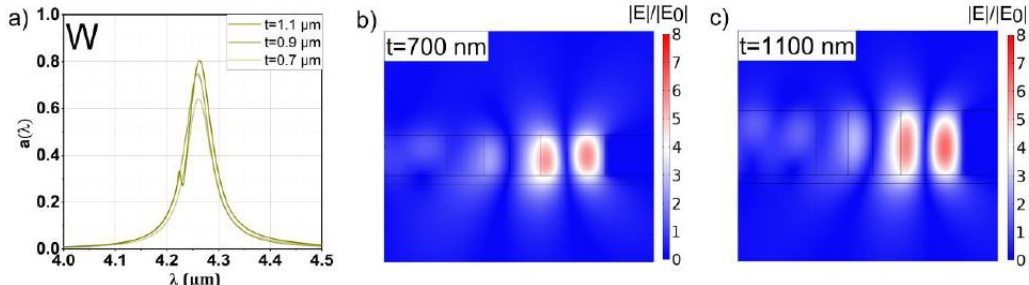
Figure 5. ( a ) Spectral response of the µ -GA optimized W-based STP structures for slab thicknesses of 0.7, 0.9 and 1.1 µ m, respectively, and a resonant wavelength of 4.26 µ m. The relative field enhancements of the thinnest (0.7 mm) and thickest (1.1 µ m) slab are shown in panels ( b , c ), respectively. The Q factor of the resonance is reflected by a 5- to 6-fold enhancement of the electric field depending on 𝑡 .